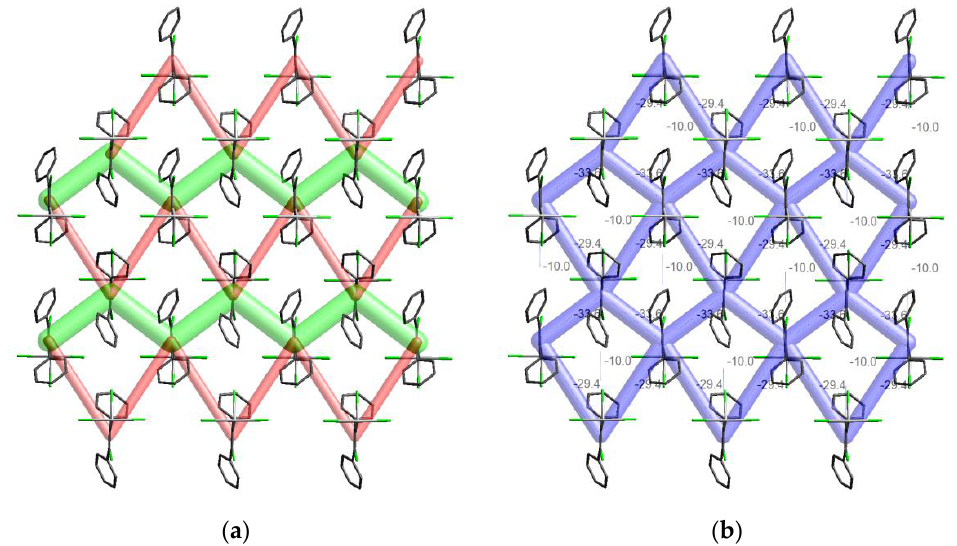
Figure 8. Energy frameworks of 1 α , showing the contribution of dispersion and electrostatic interactions into the total intermolecular interaction energy ( a ) and total intermolecular interaction energy ( b ). Color code: red (electrostatic, cut-off 20 kJ/mol), green (dispersion, cut-off 25 kJ/mol). Blue cylinders show total energy framework (Crystal Explorer 21.5, cut-off 12 kJ/mol). Intermolecular interaction energy values are indicated in kJ/mol.